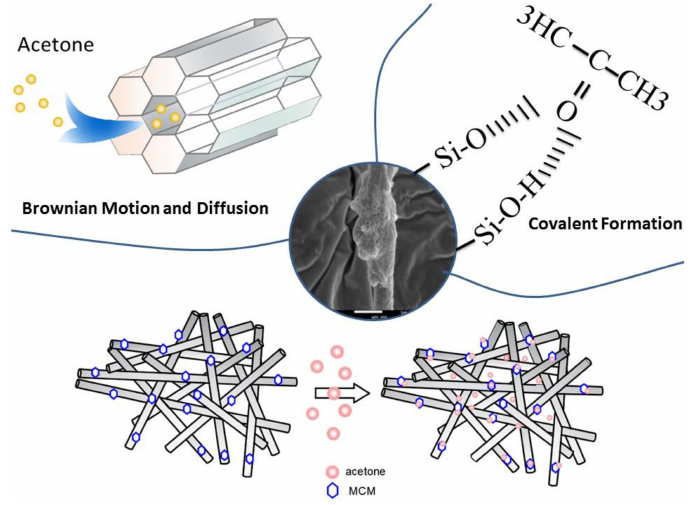
Figure 13. A diagram about the honeycomb fiber adsorption process of